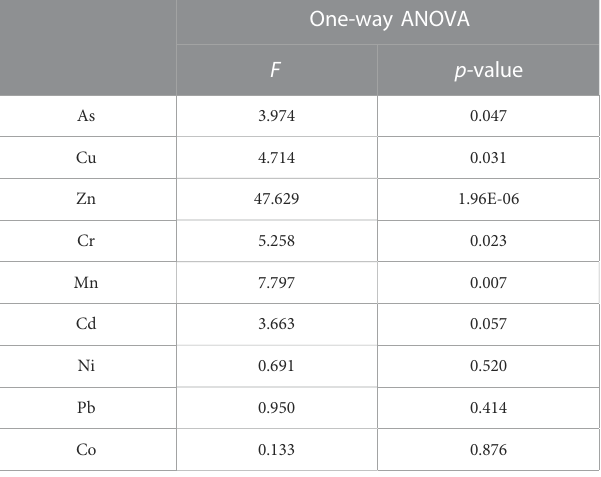
TABLE 6 Statistical analysis (one-way ANOVA) of the heavy metal concentrations (mg/kg) in roadway dust collected from roadsides (left and right) and traf fi c median along the Abu Dhabi Highway.